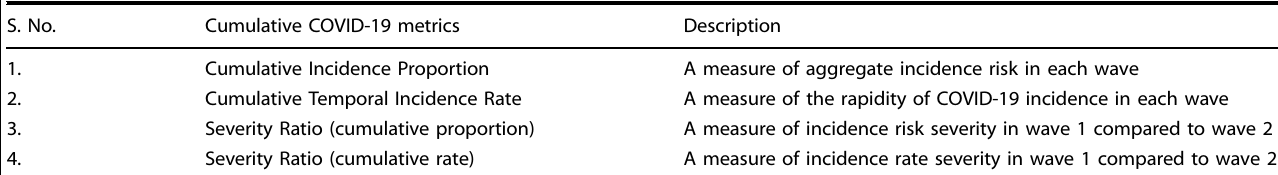
Table 1. Cumulative COVID-19 metrics analyzed in this study using COVID-19 incidence data across the two dominant waves. S. No.